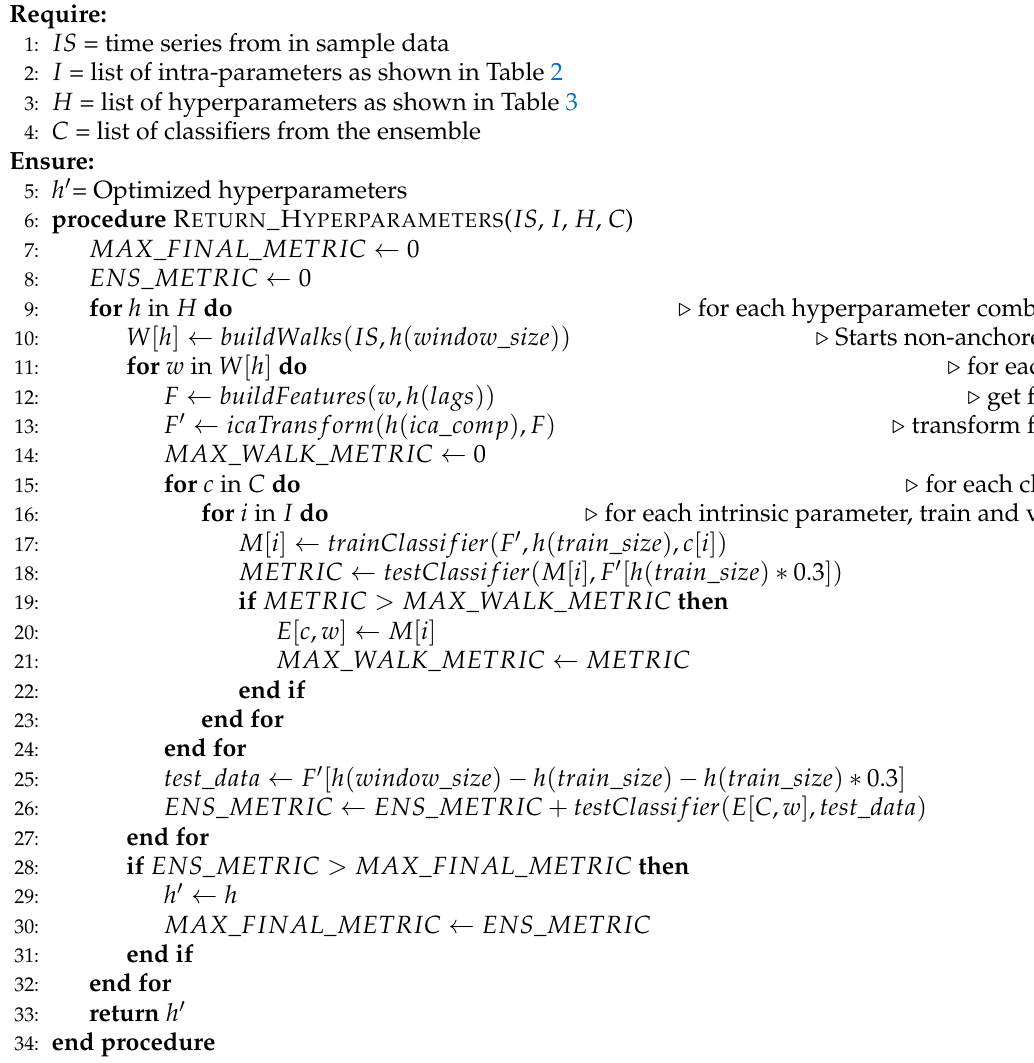
Algorithm 1 Proposed hyperparameter search